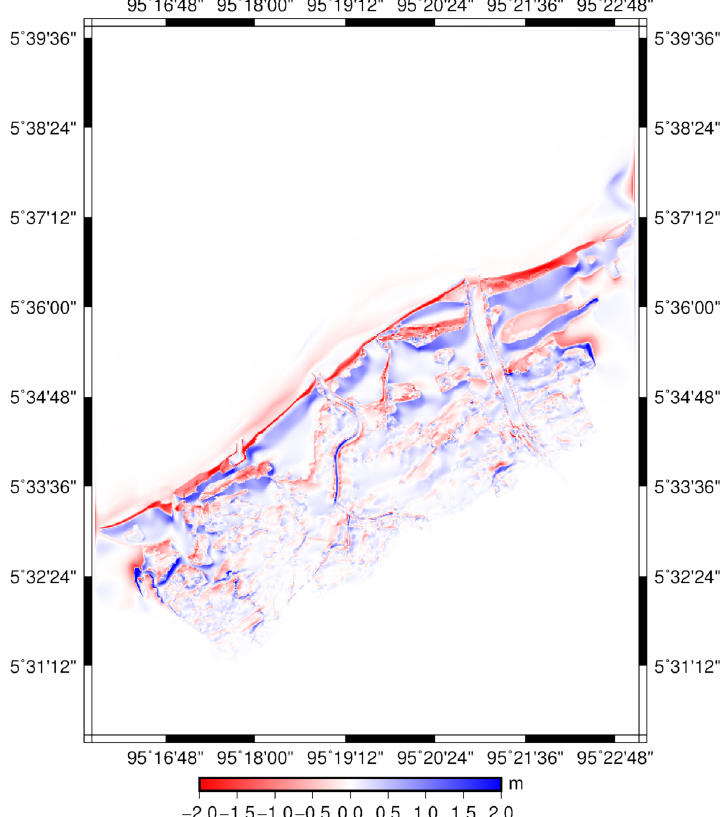
Figure 8. Map of erosion and deposition areas. Red color indicates negative (erosion) and blue indicates positive